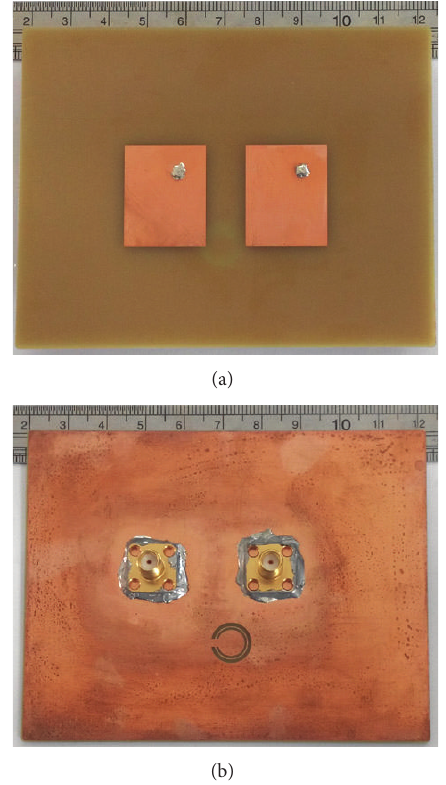
Figure 7: The prototype of the patch array. (a) Top view without DGS; (b) bottom view with